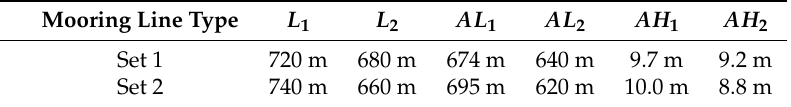
Table 3. Parameters of two sets of mooring lines for asymmetrical seabed condition with water depth h = 200